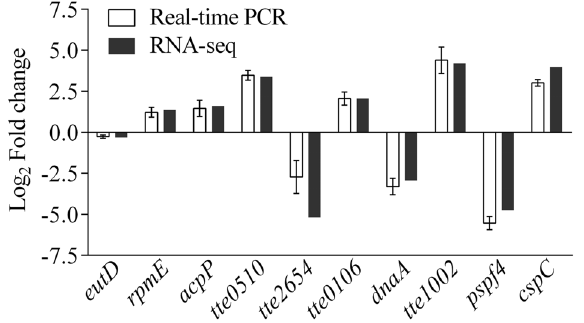
Figure 3. Validation of differentially expressed genes by real- time PCR. Comparison of RNA-seq and real-time PCR measures of changes in expression of eutD (encoding phosphotransacetylase), rpmE (50S ribosomal protein L31), acpP (acyl carrier protein), tte0510 (hypothetical protein), tte2654 (hypothetical protein), tte0106 (hypo- thetical protein), dnaA (chromosome replication initiator DnaA), tte1002 (hypothetical protein), pspf4 (a transcriptional regulator), and cspC (cold shock protein). All data are shown as means 6 SD